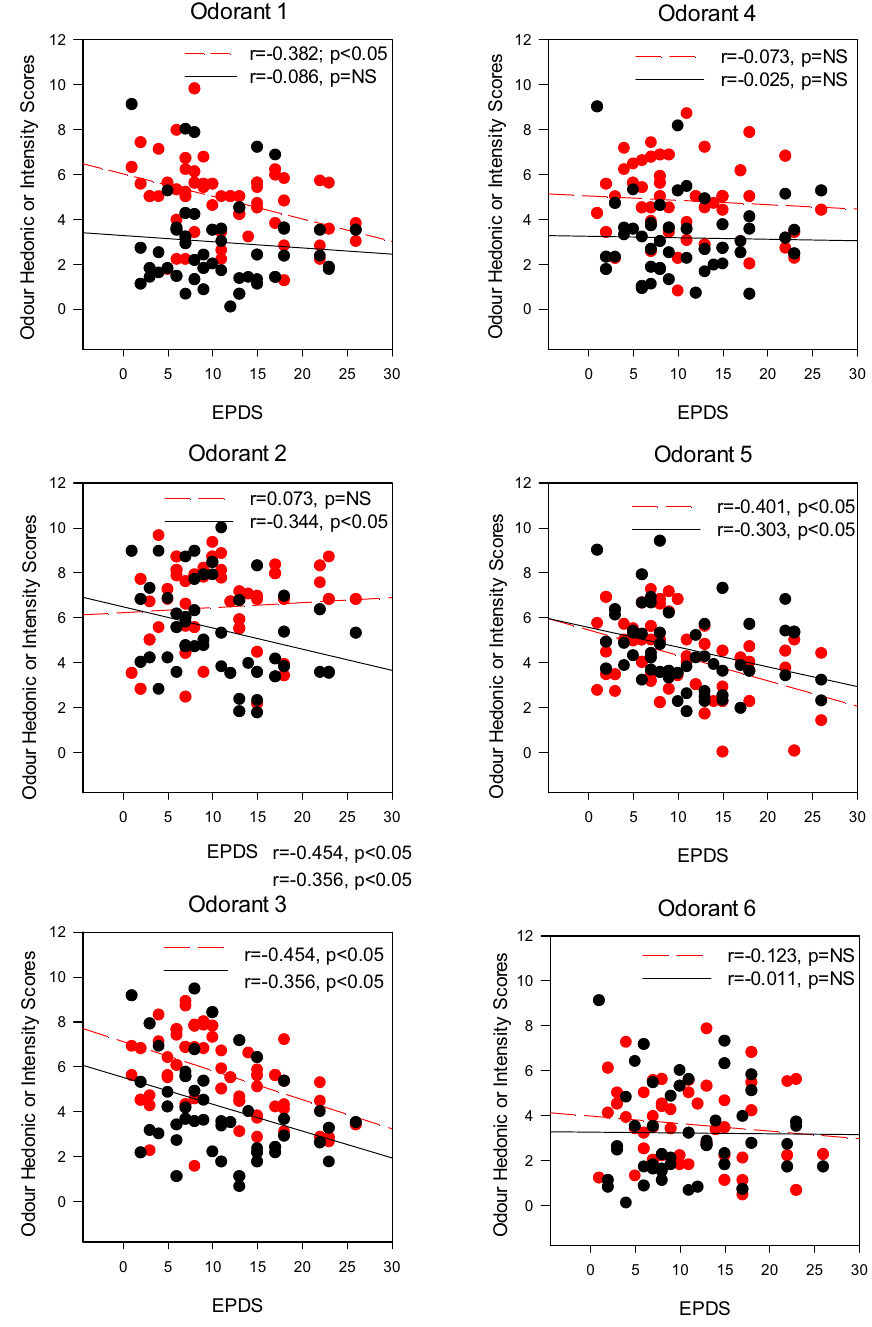
Figure 2. Scatter plots, with simple regression line, illustrating relationships between depression scores (based on Edinburgh Postnatal Depression Scale) and self-reported ratings of intensity (black) and valence (red) to six testing